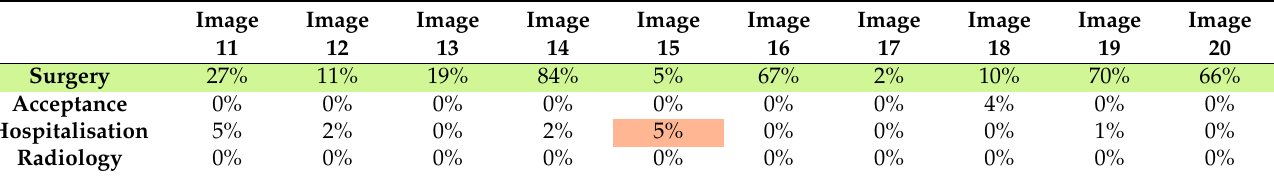
Table 7. Results obtained with the first version of the customised model for the “surgery” IU. Each column refers to one of the test images (11 to 20) and each row shows the labels that were returned by the model. The row–column intersection shows the success rate in recognising the concept stated in the row for the image in that column.